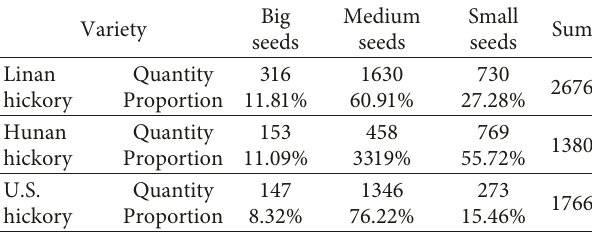
Table 1: Laying data of samples.